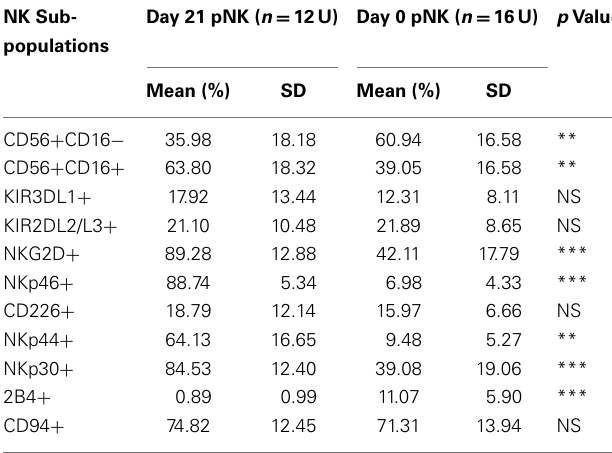
Table 8 | Sub-population comparison of Day 21 expanded pNK versus unexpanded pNK cells.